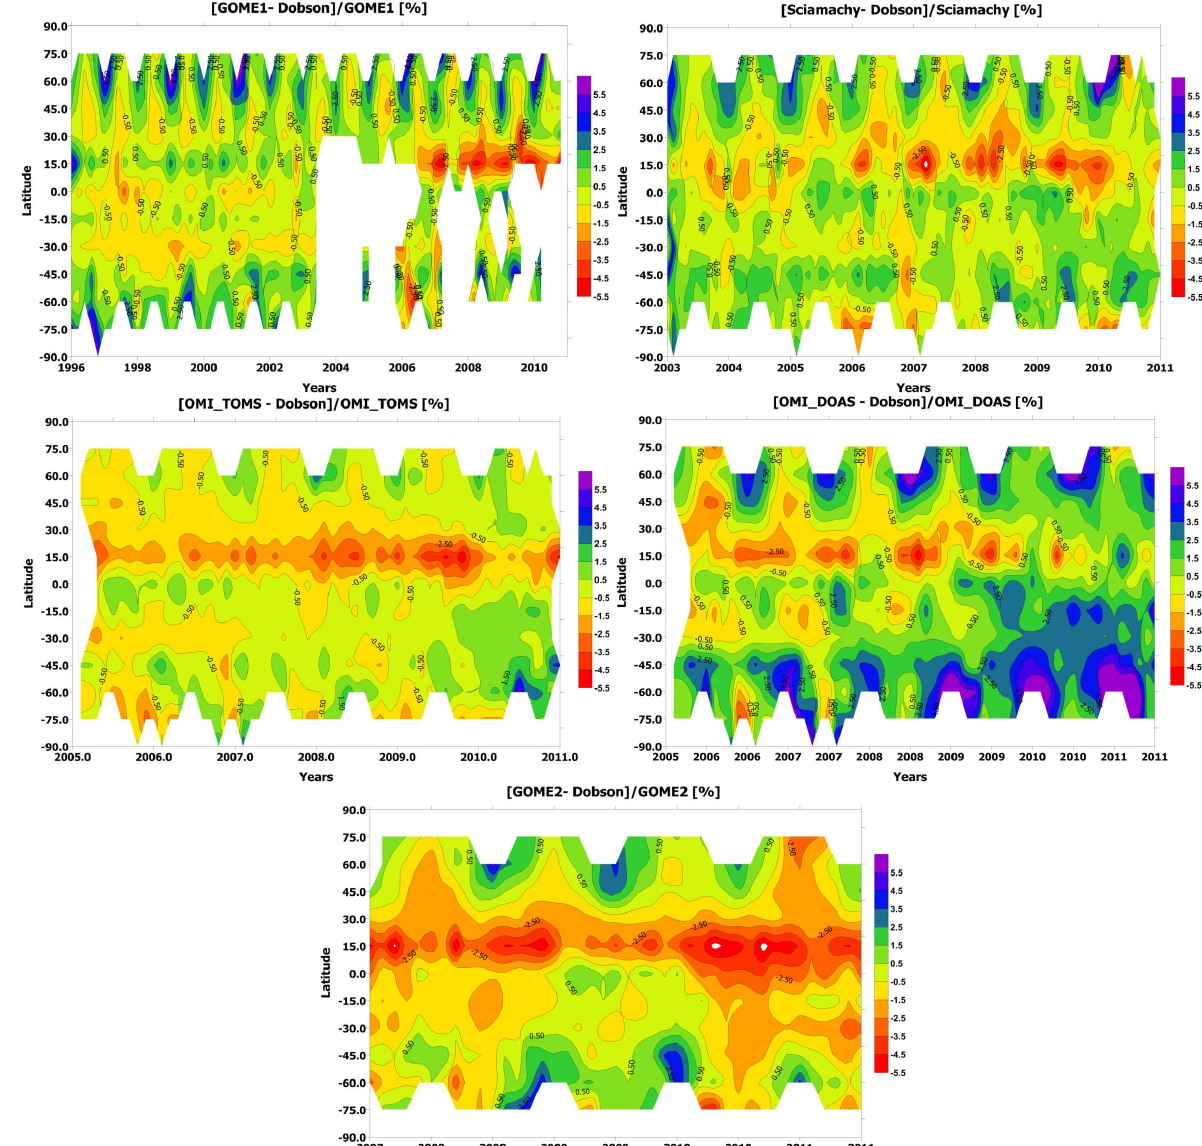
Fig. 1. Contour representation of the difference between satellite and Dobson ground-based measurements for the five datasets dis- cussed in this paper as a function of latitude and time. Top left: GOME. Top right: SCIAMACHY. Middle left: OMI TOMS. Middle right: OMI DOAS. Bottom: